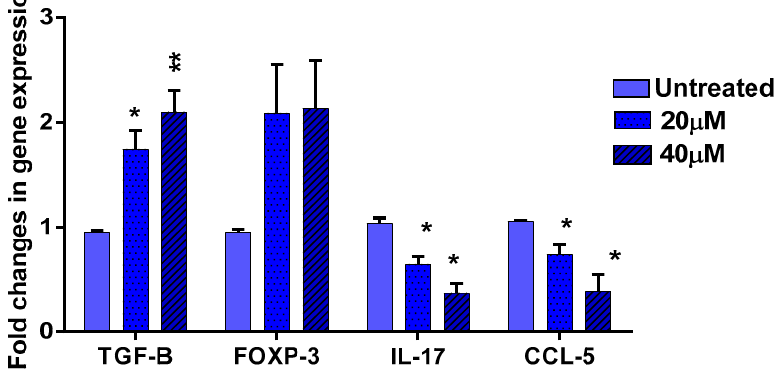
Figure 6. The effect of EGCG treatment was studied on a group of inflammatory-regulatory genes involved in IP in immortalized lymphocytes. Following induction with IFN- γ , Jurkat cells were treated with 40 mM EGCG for 48 h and expression of IL-17, CCL-5, FOXP3, and TGF- β investigated by Q-PCR. CT values were normalized to GAPDH and differential expression (2ˆ − ∆∆ CT) of AA candidate genes in EGCG treated samples was calculated against untreated samples. Data represented as mean ± SEM ( n = 4). Significant difference * p < 0.05, ** p <